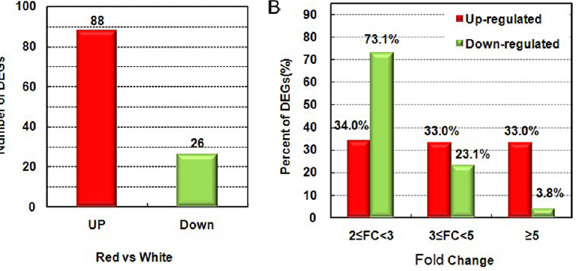
Fig 2. Analysis of differentially expressed genes (DEGs). (A) Numbers of up- and down-regulated genes between red- and white-fleshed fruits at the ripe stage. (B) Distribution of fold changes (FC) for up- and down- regulated genes at the ripe stage.